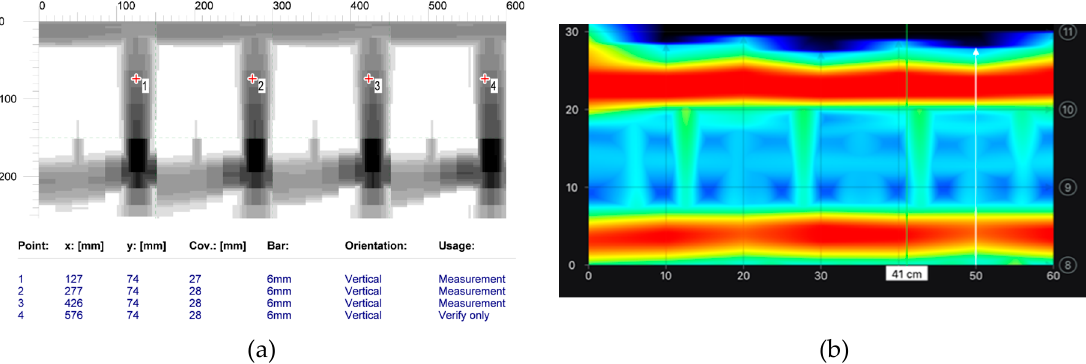
Figure 14. Line scans (measurement at points shown in Figure 10c) with devices: ( a ) electromagnetic 1, average cover of visible results—27.8 mm, ( b ) electromagnetic 2, average cover—28.6 mm, ( c ) radar 3, average cover 27 mm. Materials 2019 , 12 FOR PEER REVIEW